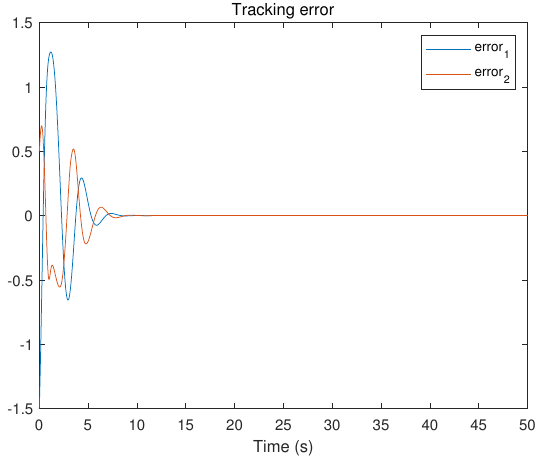
Figure 6. Tracking error trajectories when η 1 = 1 and η 2 = − 1.